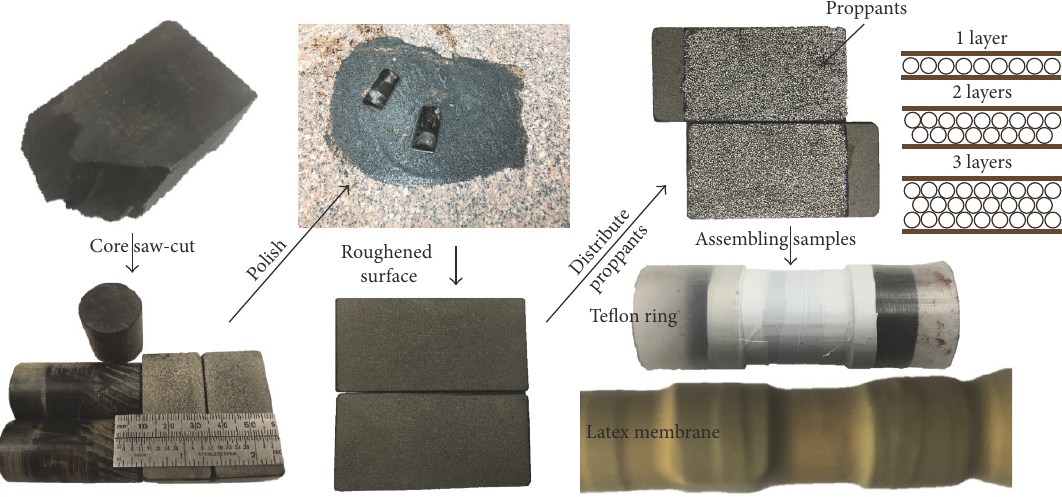
Figure 2: Procedures of sample preparation.